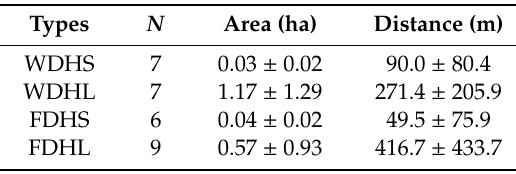
Table 3. Characteristics of selected home gardens in woody-dominated home gardens (WDH) and fruit-dominated home gardens (FDH) with its landholding size.